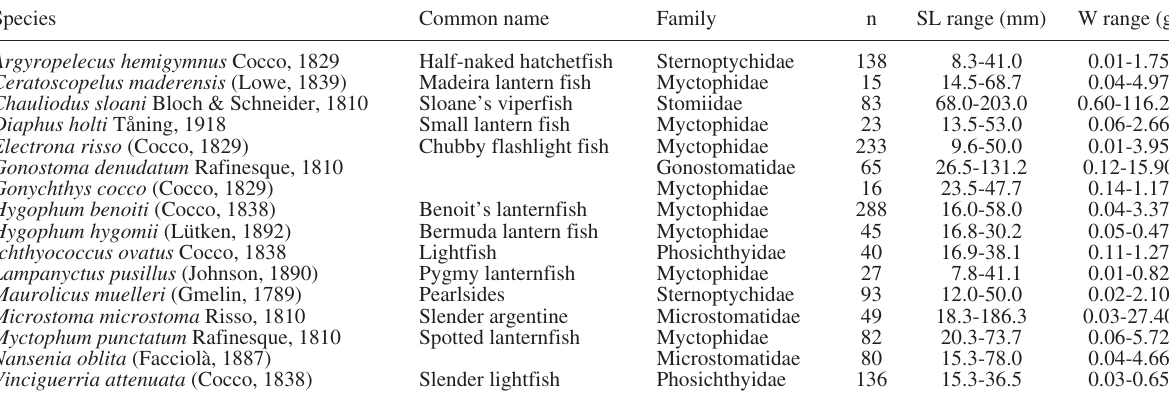
weights (W) are given.